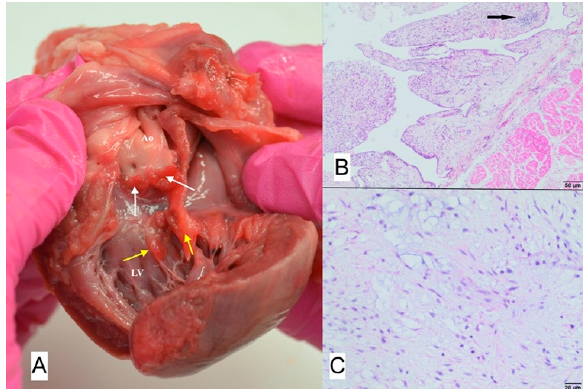
Figure 9. ( A ) Macroscopic view of thickened aortic and mitral valves. White arrows point to the aortic valve leaflets, yellow arrows points to the mitral valve, Ao—Aorta, LV—left ventricle. ( B ) Microscopic view: myocarditis with multifocal necrosis of cardiomyocytes, and moderate inflam- matory infiltrate consisting of histiocytes and lymphocytes; H-E; magnification. 100× and prolifera- tive pericarditis end endocarditis with mild multifocal lymphocytic inflammatory infiltrate and pro- liferation of fibrous tissue with maturation to muco-fibroid tissue in subserosal layer of serosal membranes. Exophytic proliferation of fibrous tissue covered by mesothelium with sparse lym- phoid inflammatory infiltrate–arrow; H-E, magnification. 4×. ( C ) Close view of mature connective tissue with accumulation of muco-fibrous matrix; H-E, magnification 100×.